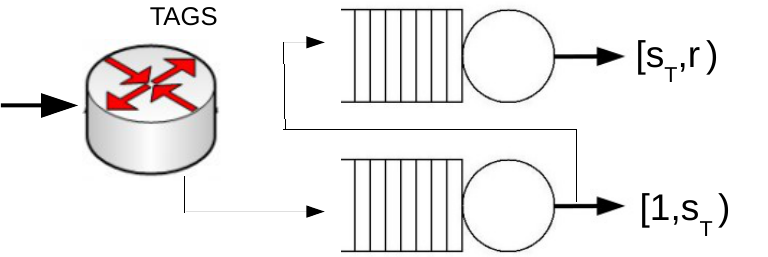
Figure 1. A system with two servers that operates under Task Assignment with Guessing Size (TAGS).